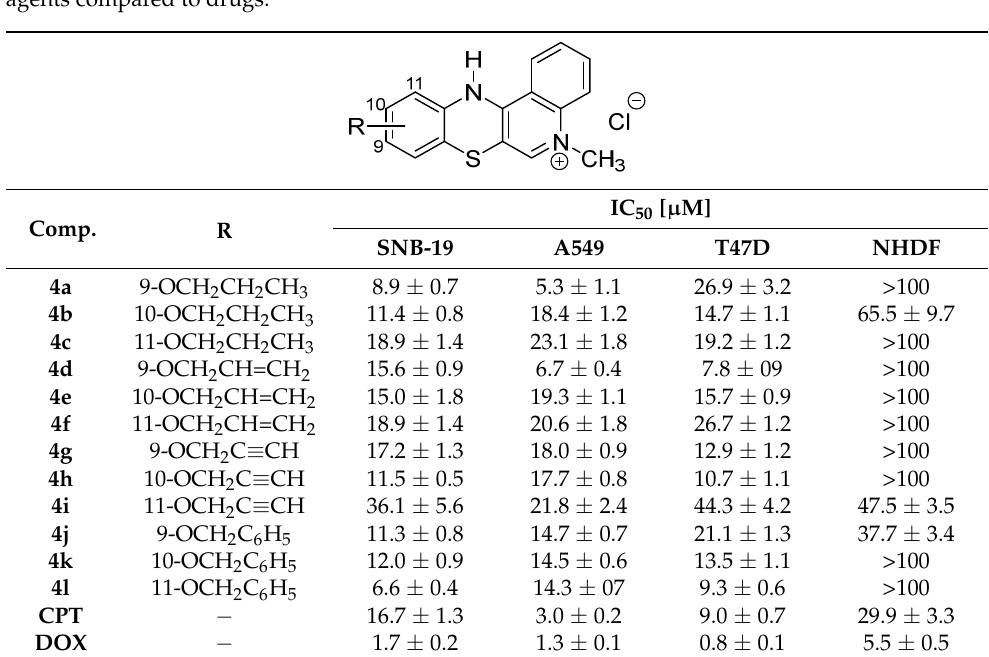
Scheme 1. Synthesis of alkoxy 5-methyl-12 H -quino[3,4- b ][1,4]benzothiazinium chlorides 4a – l . Reagents and conditions: ( a ) pyridine, 20–80 ◦ C; ( b ) pyridine, HCl, O 2 [53]. Table 1. Structures of discussed agents 4a – l and in vitro antiproliferative activity against human cancer cell lines and cell viability of normal human cells (IC 50 [ μ M] ± SD, n = 6) of investigated agents compared to drugs.